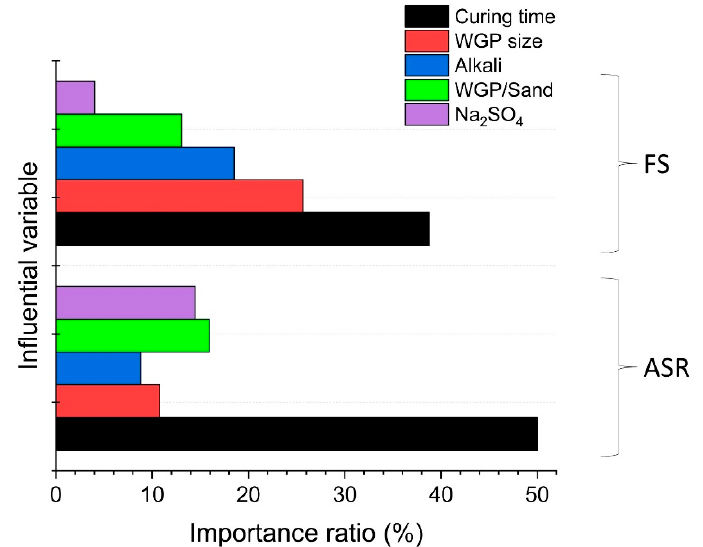
Figure 14. Variables significance on FS and ASR expansion of WGP mortar mixture design.